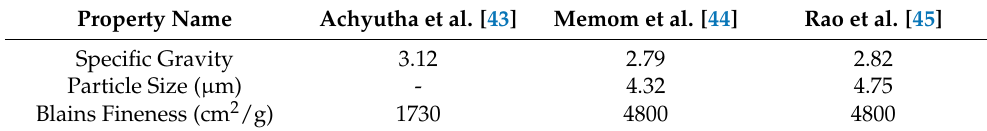
Table 1. Physical properties of bentonite clay.